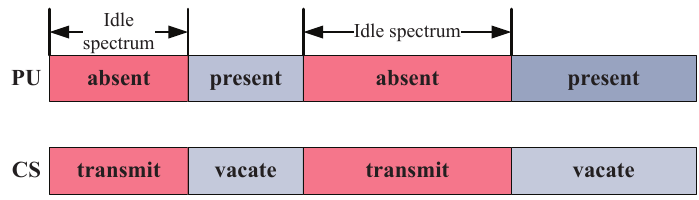
Figure 1. Idle spectrum utilization of the cognitive sensor.